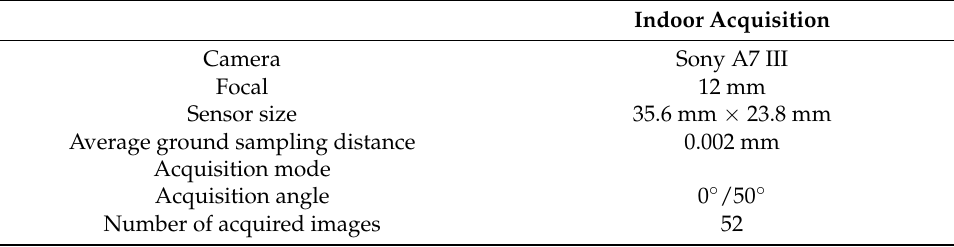
Figure 5. The mesh textured model and orthophotos obtained using Agisfot Metashape. Table 2. Church indoor acquisition